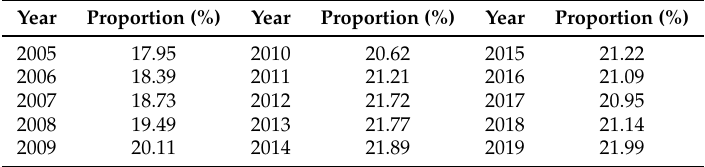
Table 2. Proportion of the core collection considering all DDC classes as a whole for each